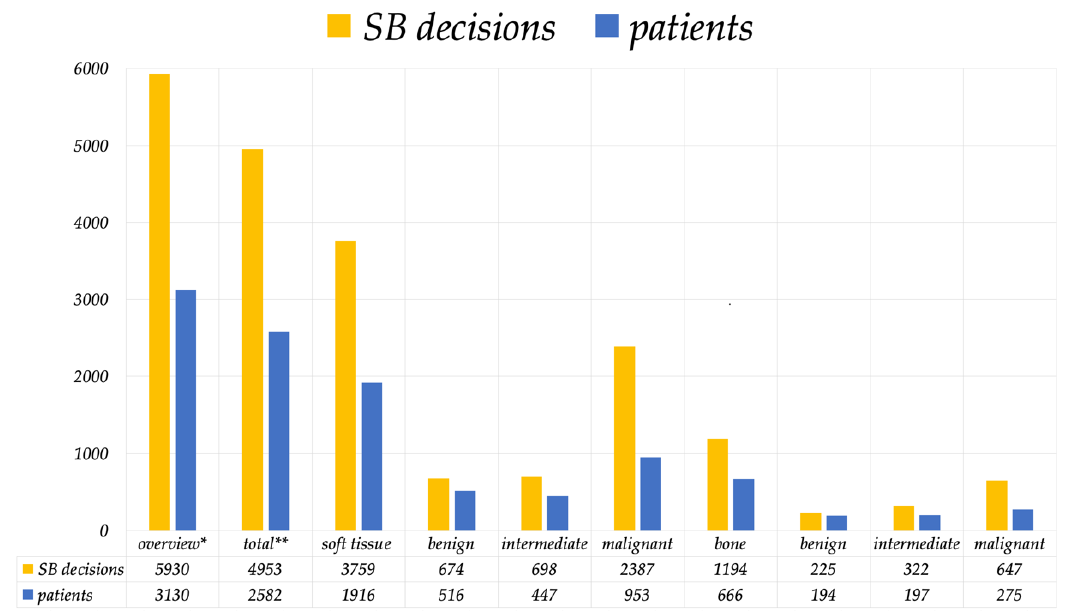
Figure 2. This figure summarizes the number of sarcoma board decisions and patients over a 10- year period. * All evaluations of mesenchymal tumors ** Exclusive metastasis, carcinoma, lym- phoma, leukemia, myeloma, and tumor simulator.